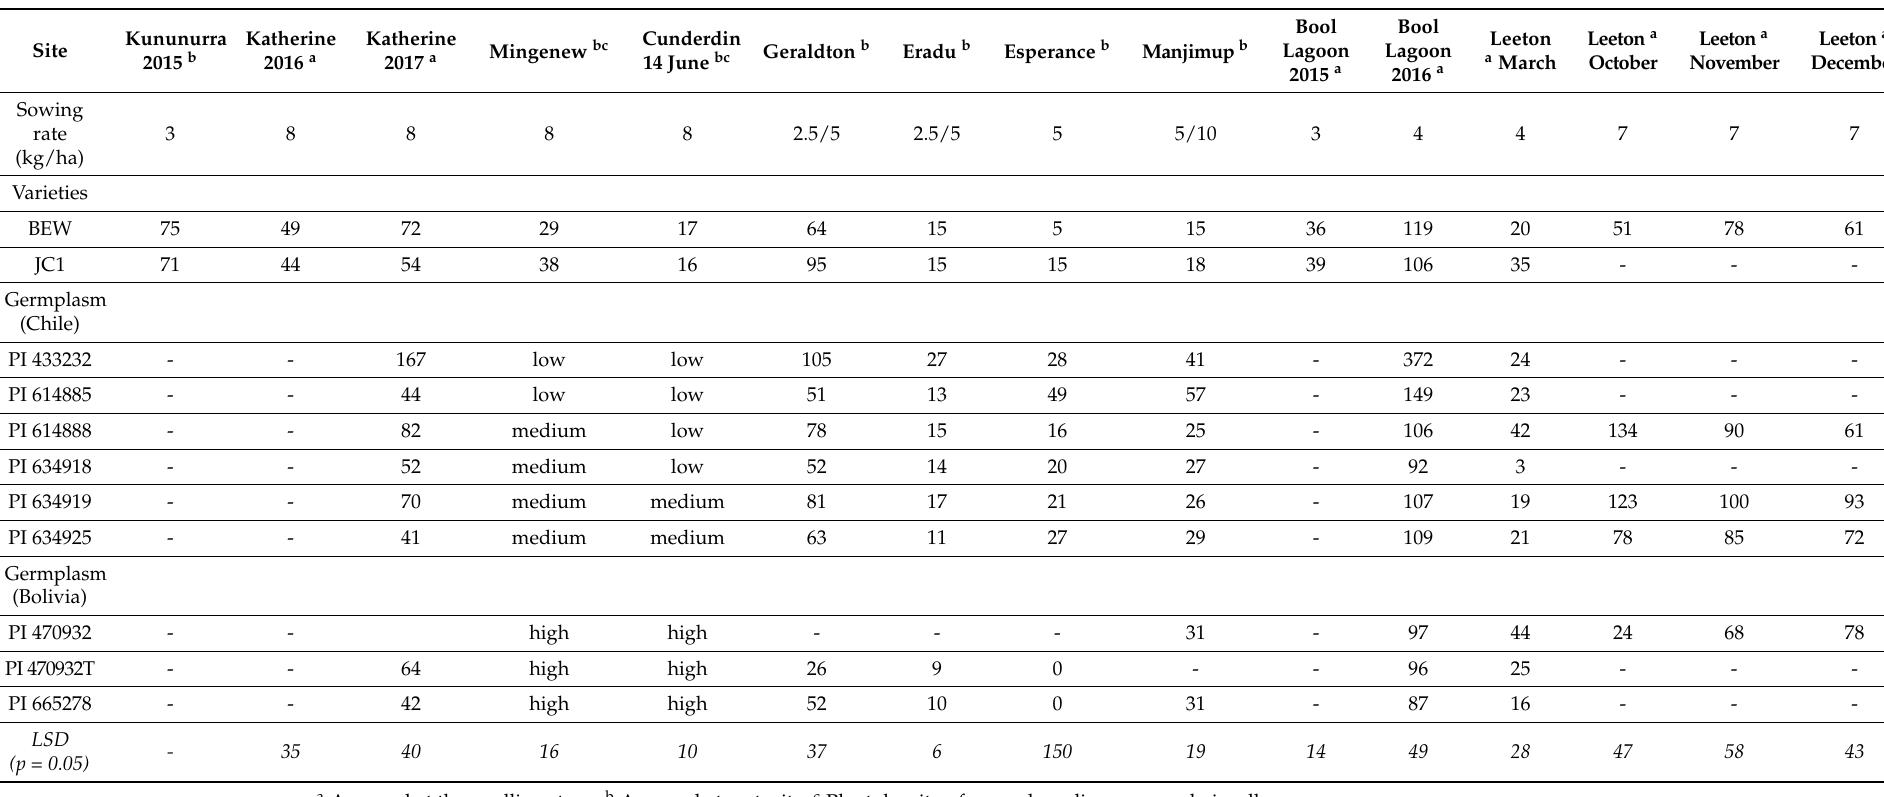
Table 7. Plant density at selected trials assessed at maturity or at establishment (plants/m 2